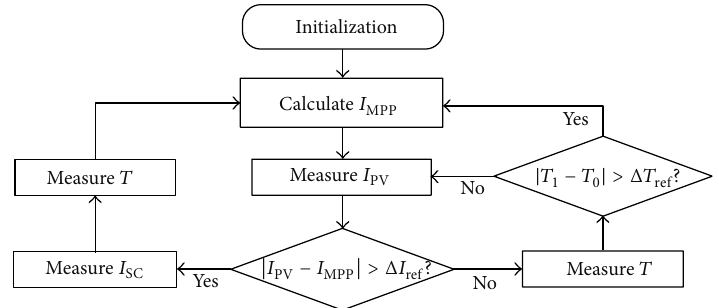
Figure 8: Flowchart of the proposed method.